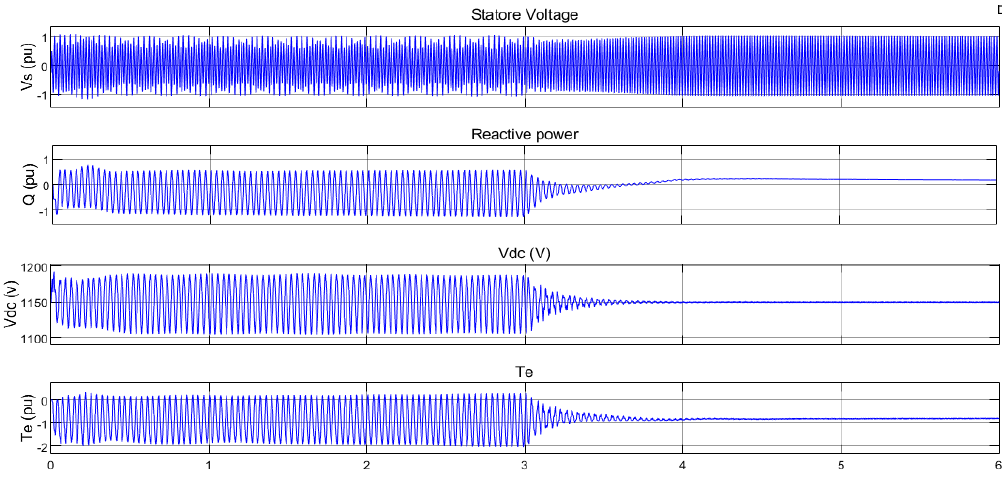
Figure 9. Damping of capacitor voltage, reactive power stator voltage, and electrical torque in k = 75% & v = 7 m/s with FLWADC (ignoring time